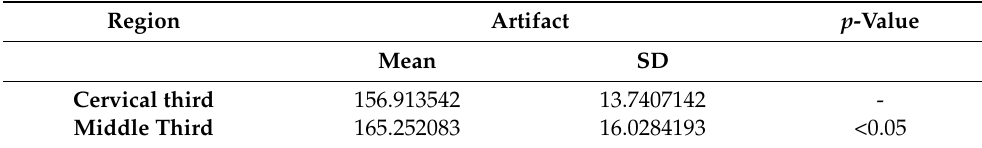
Table 2. Artifact comparison by region.